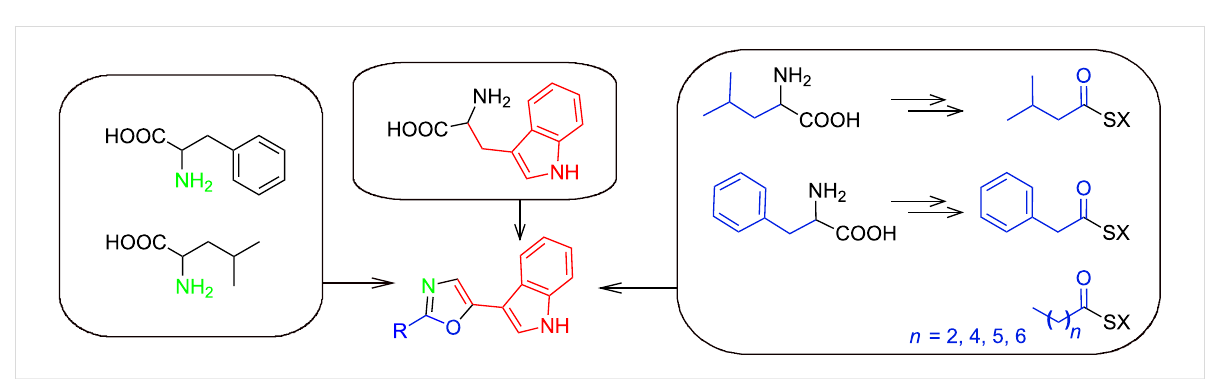
Figure 3: All incorporated biosynthetic precursors of the oxazoles are shown in color. The nitrogen shown in green is derived from transamination as part of the amino acid metabolism. SX = activated ester, which may be coenzyme A or enzyme (acyl carrier protein or polyketide synthase or nonribo- somal peptide synthetase)